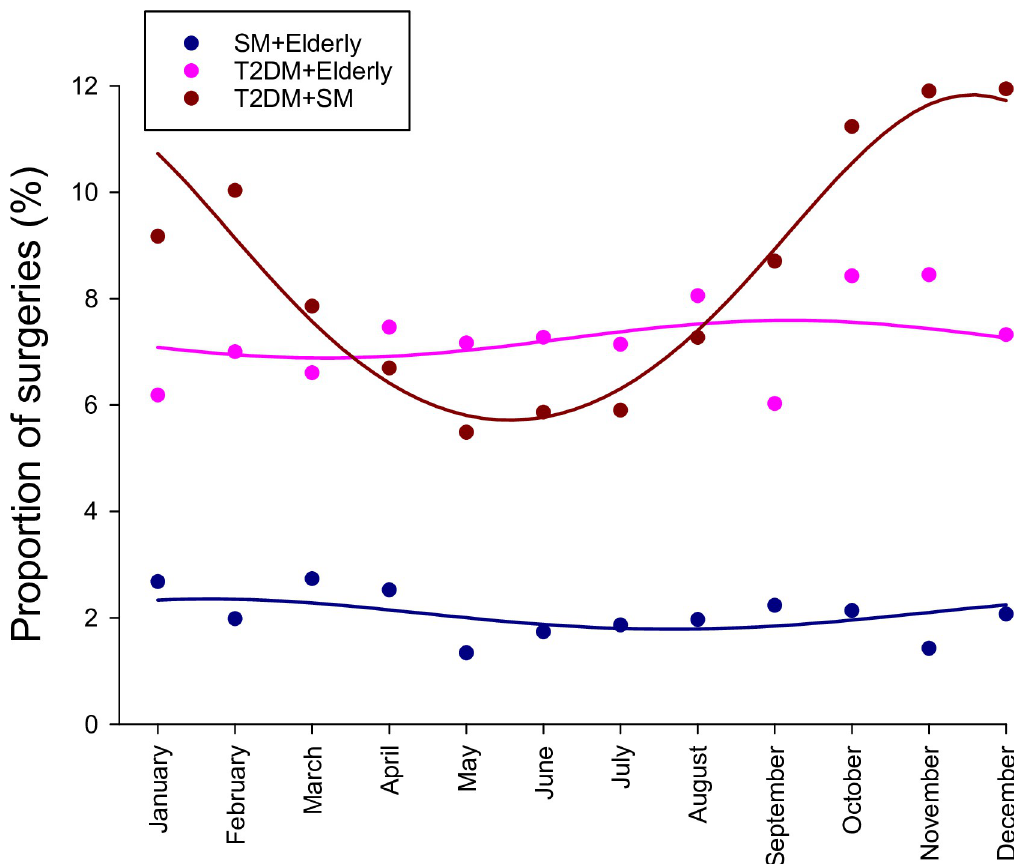
Fig 3. Seasonal changes in the proportion of surgeries associated with combined smoking and aging (SM + Elderly), type 2 diabetes mellitus and aging (T2DM + Elderly), and type 2 diabetes mellitus and smoking (T2DM + SM) for the monthly aggregated data over the 12-year study period (January 1, 2007 to December 31, 2018).